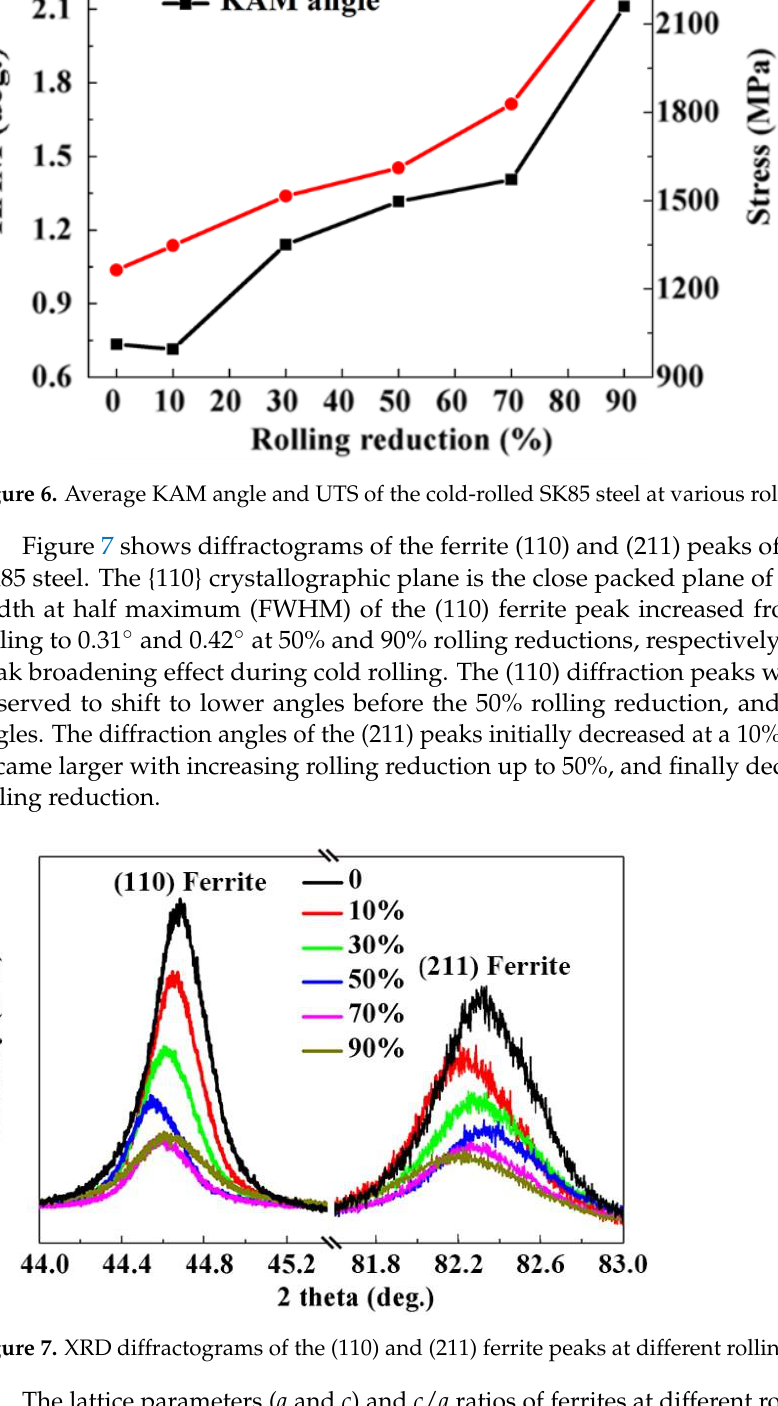
Figure 5. KAM maps of the SK85 steel before rolling ( a ) and at a rolling reduction of ( b ) 10%; ( c ) 30%; ( d ) 50%; ( e ) 70%; and ( f ) 90%.